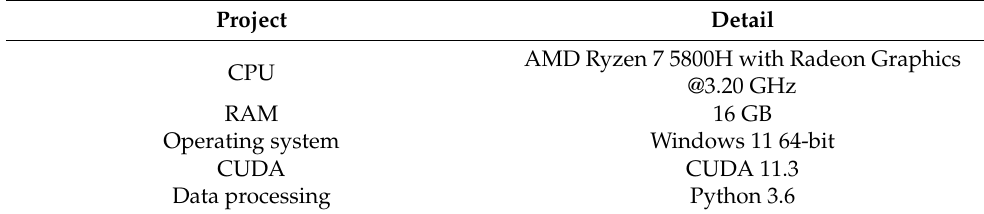
Table 3. Experimental software and hardware